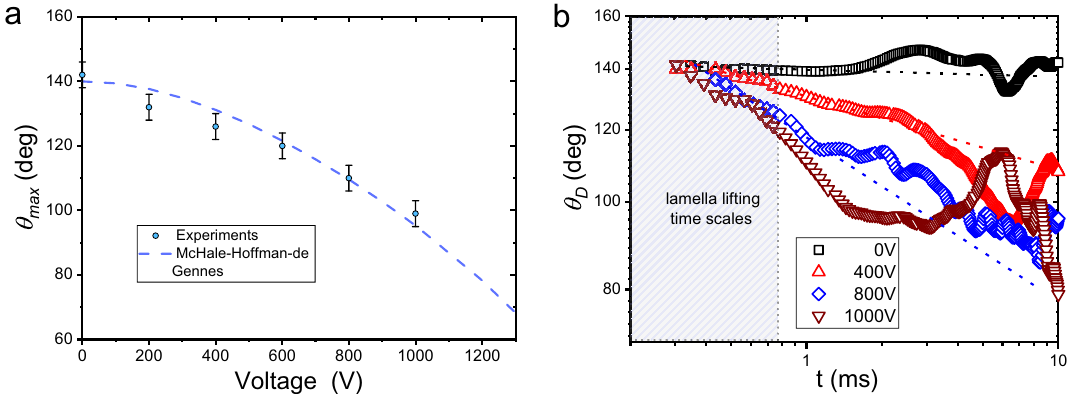
Figure 4. ( a ) Maximum advancing contact angle in terms of the electric potential strength; the McHale– Hoffman–de Gennes model with a Voltage threshold of V TH = 1600 V is seen as a dashed lines. ( b ) Dynamic contact angle in terms of time for various potential strengths at We = 52; dashed lines show exponential fits for early times (t < 1.0